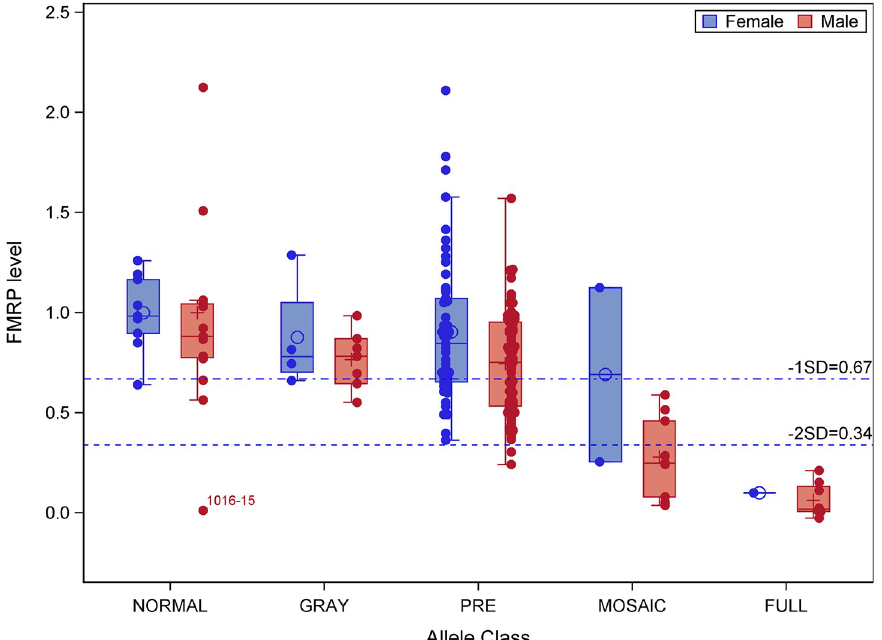
Fig 1. Distribution of FMRP levels within each allele class. Dashed lines indicate the values of FMRP 1 SD and 2 SD (as indicated) below the relative mean level (= 1.0) of those with normal CGG-repeat alleles (see, also: Fig 2). Individual 1016–15 has a normal CGG repeat (21 CGG) but has a point mutation within the FMRP coding region [80] that prevented detection by the FRET assay (See: S2 Fig).